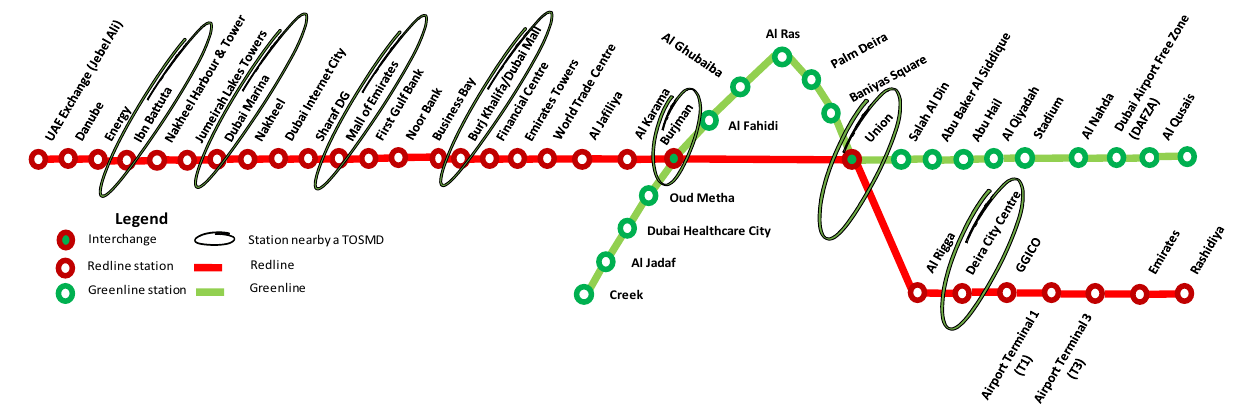
Fig. 3 Dubai Metro Red Line route map and stations within 0.8 km (circled) of the shopping malls